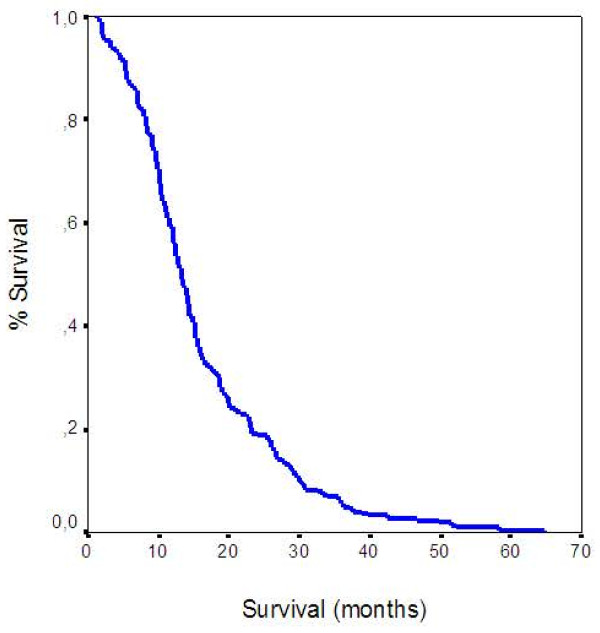
Overall Survival.